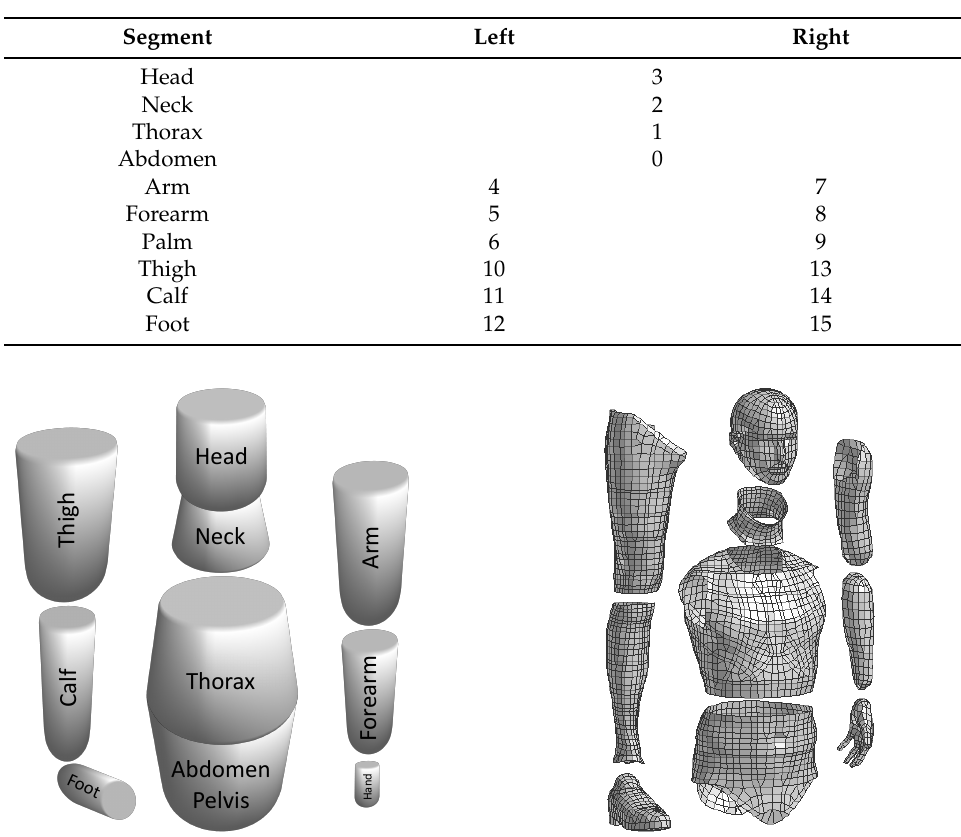
Figure 3. Human body segmentation. Methodology ( left ) and corresponding segmentation of the reference model ( right